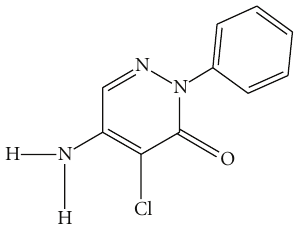
Figure 1: Structure of